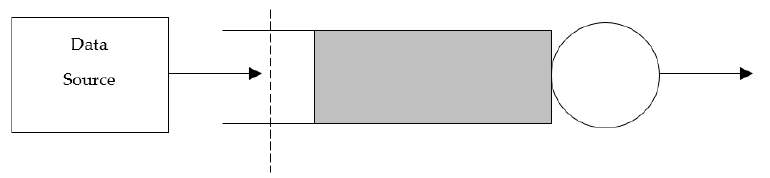
Figure 2. Queuing system model of the IoT device [26].